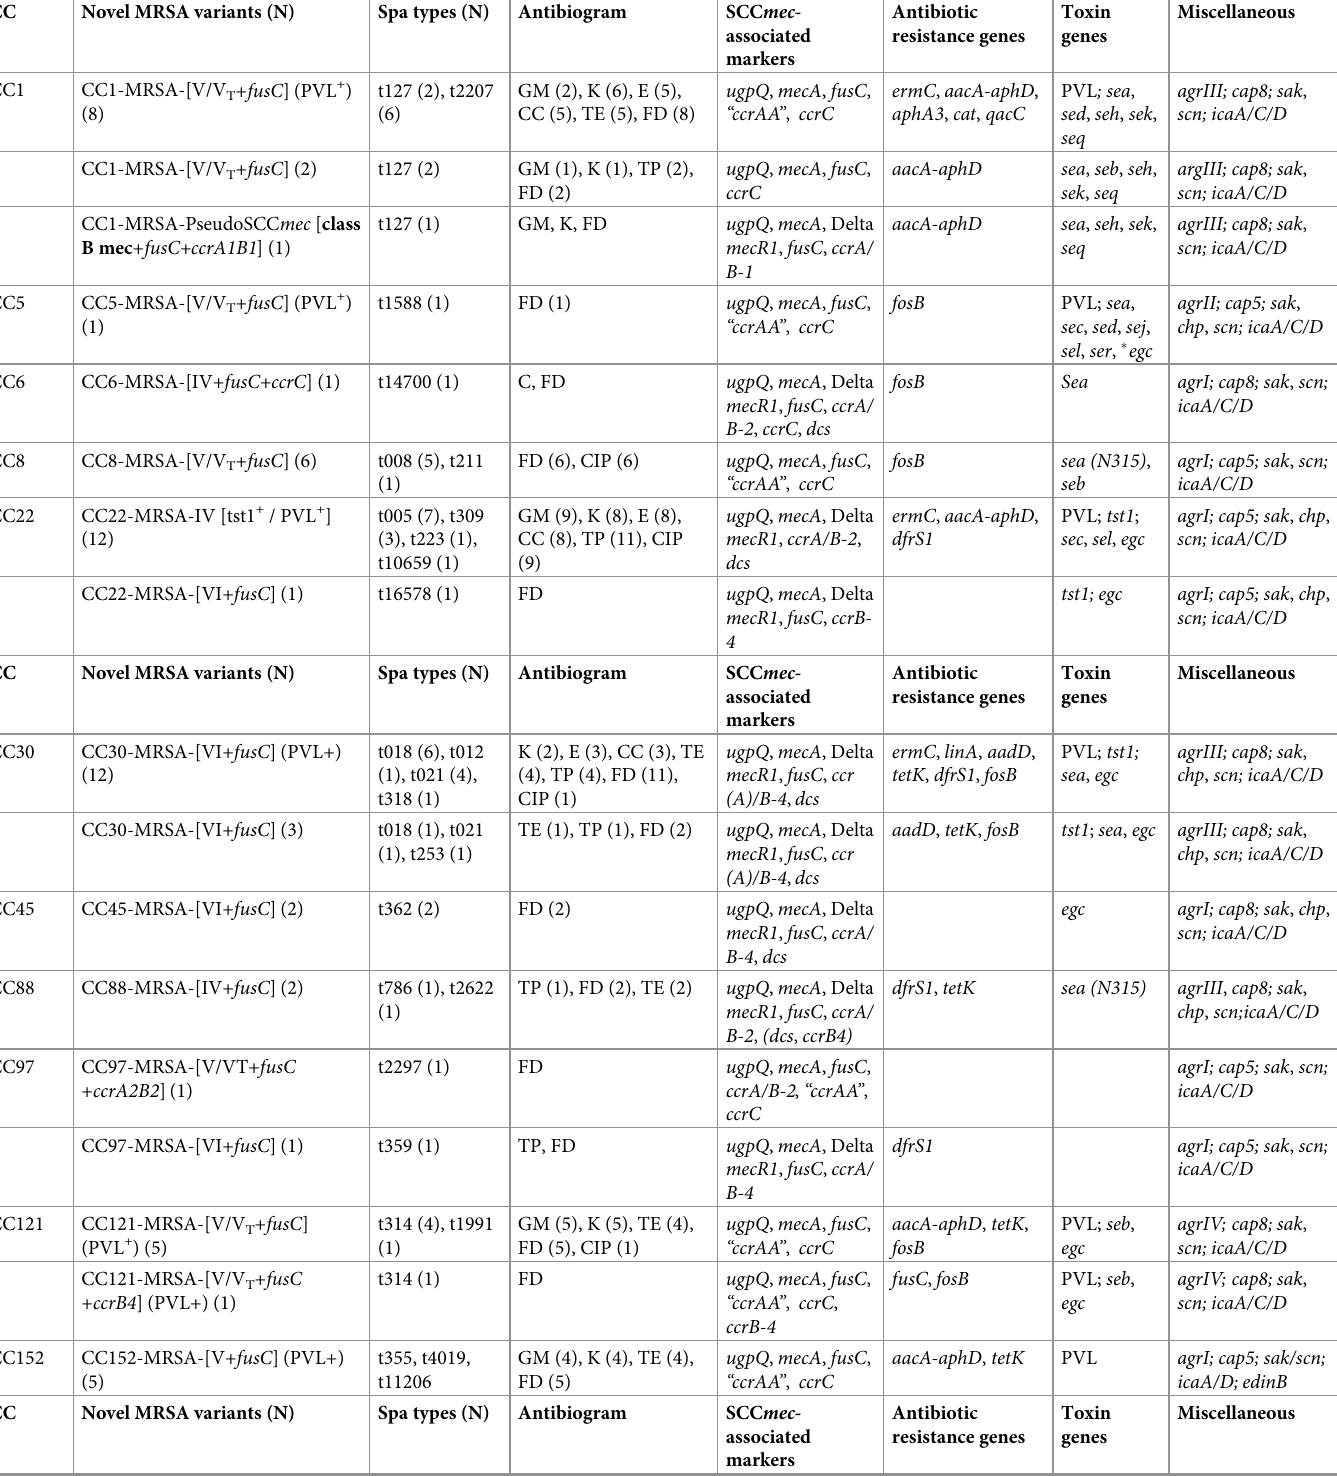
Table 1. Virulence and antibiotic resistance encoding genes of the novel MRSA